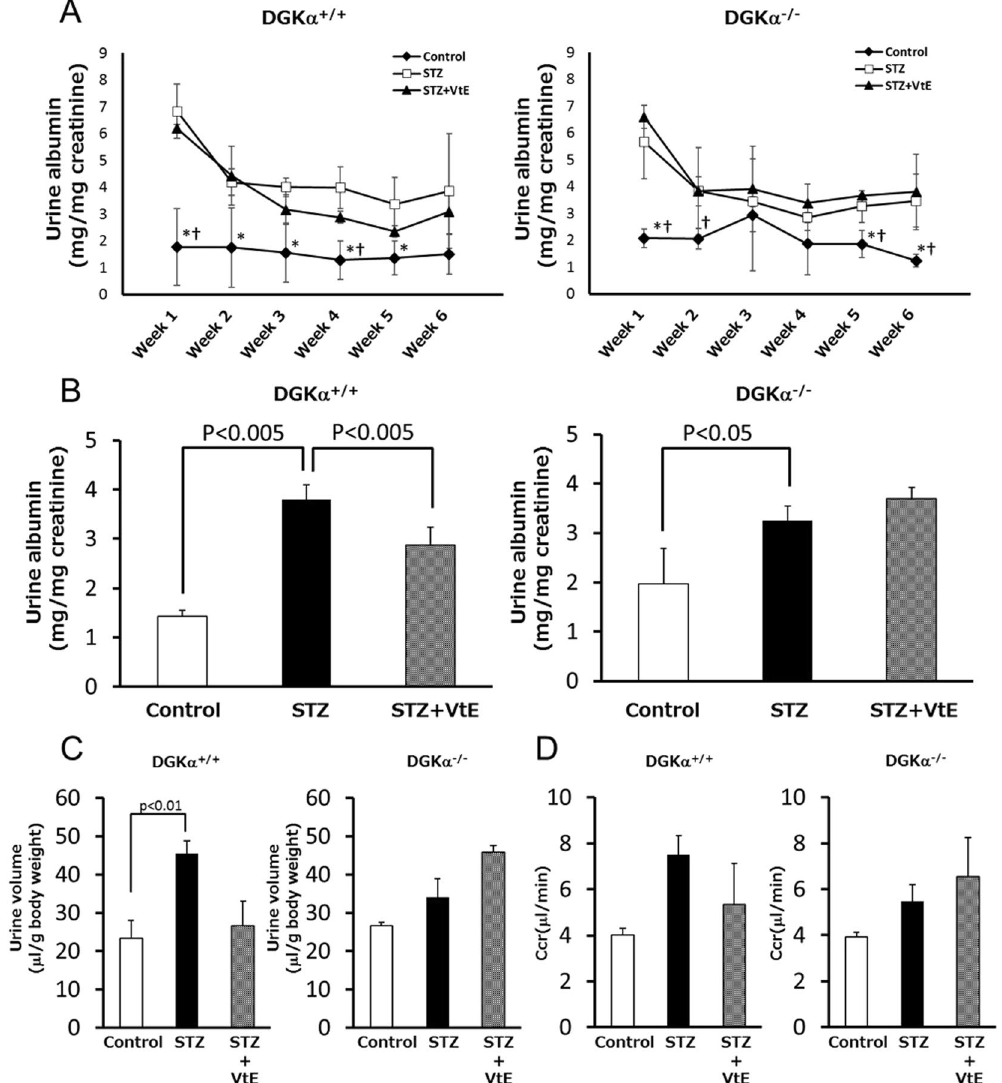
Figure 2. Indicators of diabetic nephropathy. ( A ) Urine albumin levels were measured in each group of mice from weeks 1 to 6. ( B ) The mean amount of urine albumin from weeks 3 to 6. Urine albumin levels were normalized to urine creatinine levels. ( C ) Urine volume was measured for each group of mice using metabolic cages. The bar graphs show data for urine volume at 5 weeks. ( D ) Creatinine clearance (CCr) of mice at 1 week was calculated from the concentrations of urine and plasma creatinine. * P < 0.05 vs. STZ; † P < 0.05 vs. STZ +